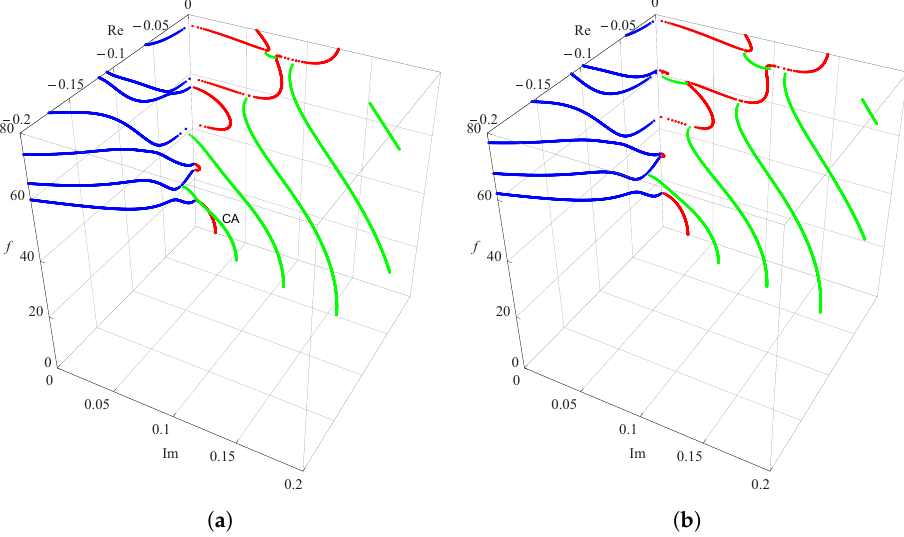
Figure 4. Dispersion curves of complex Rayleigh waves in FGPM half-space: ( a ) n = 1; and ( b ) n =